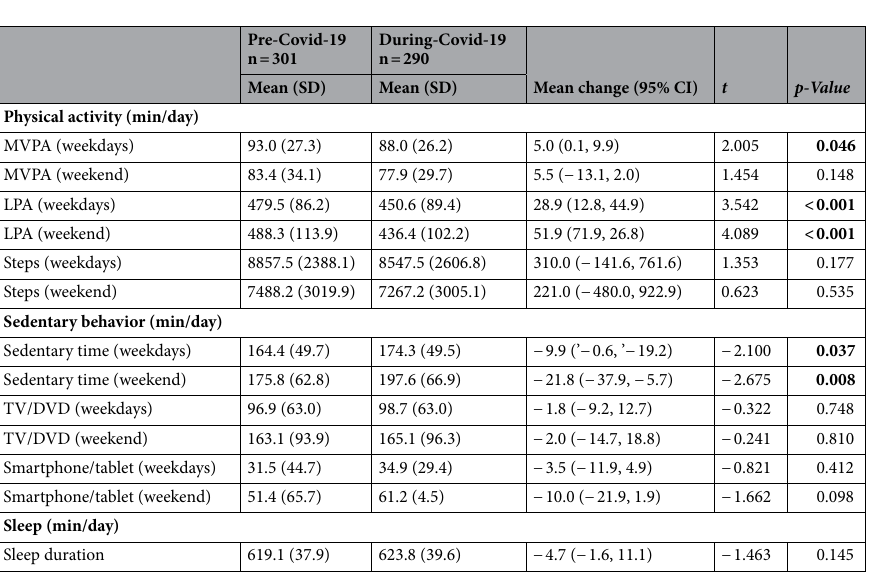
Table 2. Change of physical activity, sedentary behavior, sleep in pre- and during COVID-19 pandemic. Bold values indicate a factor of significant relevance. SD standard deviation, MVPA moderate to vigorous physical activity, LPA light physical activity, PA physical